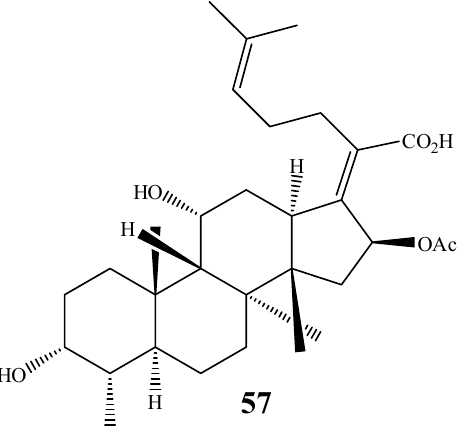
Figure 13. Chemical structure of fusidic acid ( 57